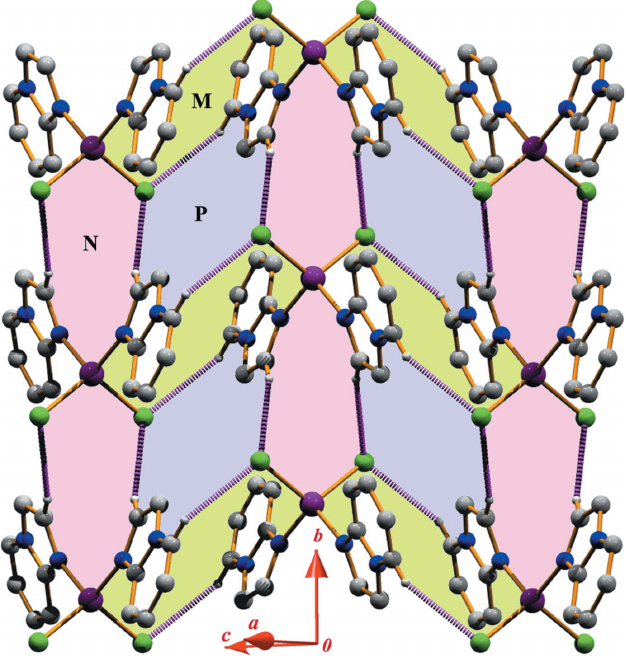
Figure 2 Formation of a two-dimensional supramolecular network , 2